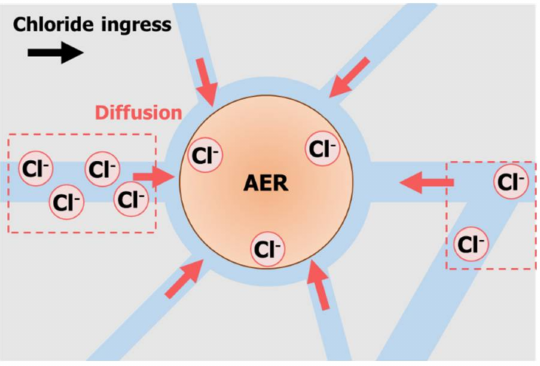
Figure 10. Schematic illustration of the chloride adsorption of the AER in the mortar